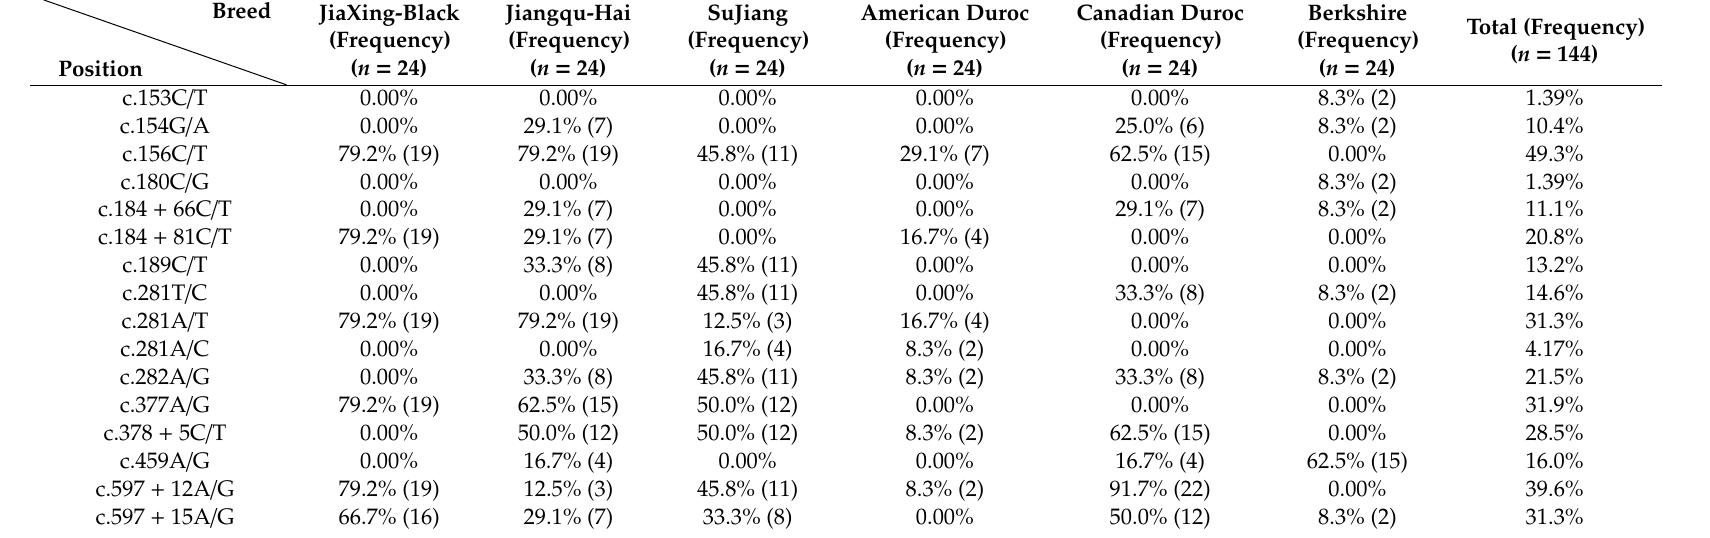
Table 4. Frequencies of the porcine variations in six